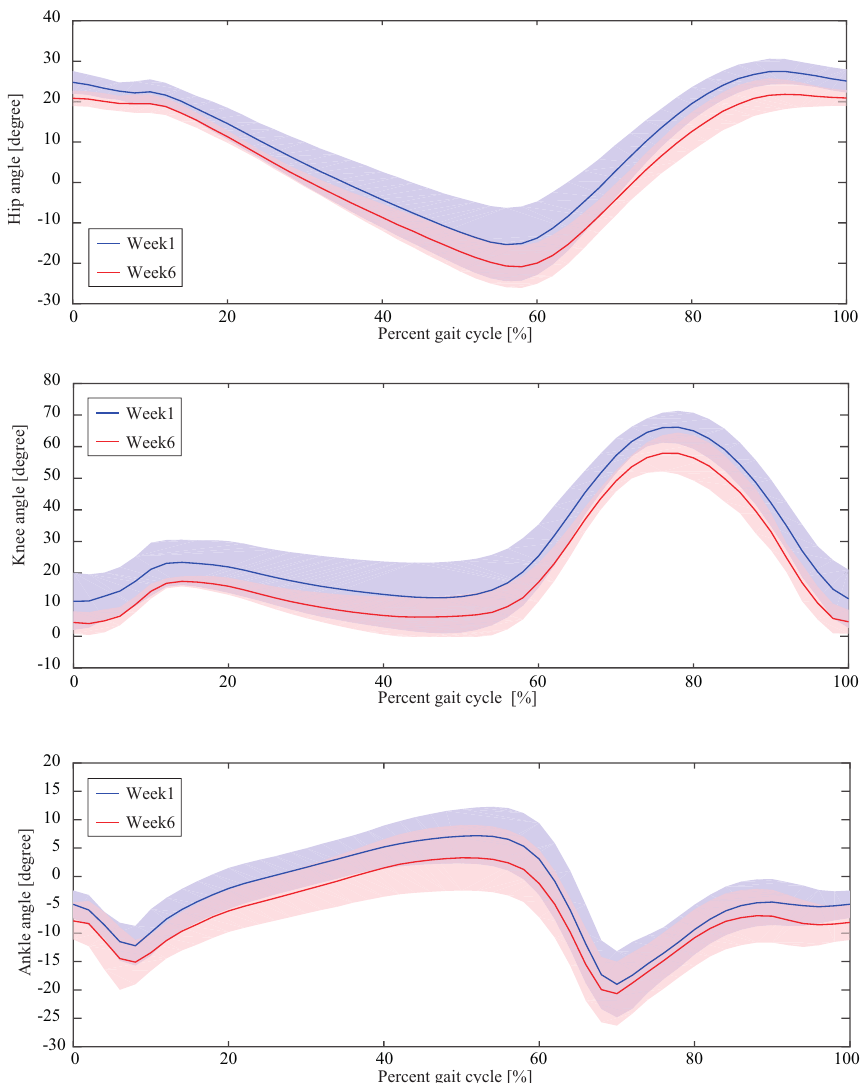
Figure 7. Comparison of joint angles achieved in the POFF condition between Week 1 and Week 6. On each graph, the solid curve represents the average value, and the shadowed region denotes one standard deviation.